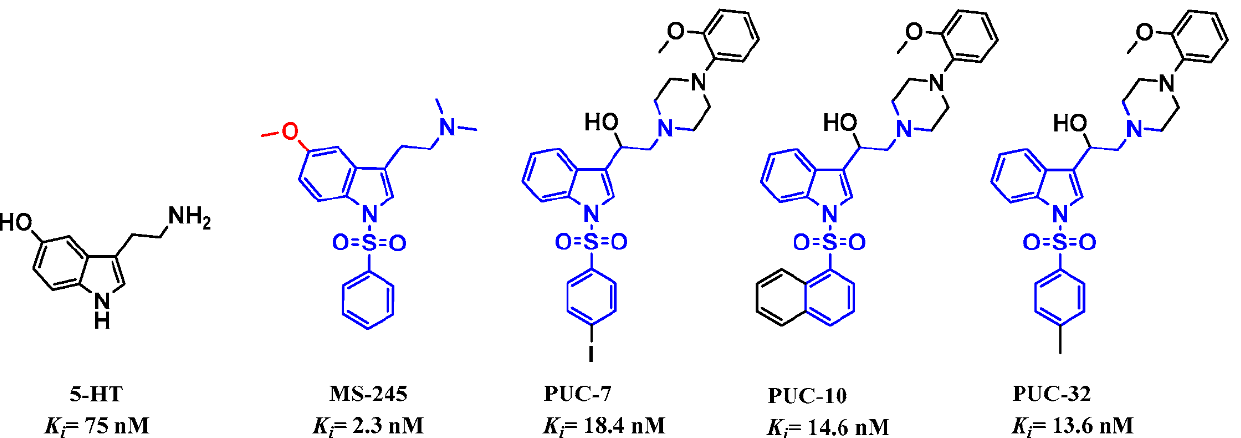
Figure 1. Structures and inhibition constants (K i ) for 5-HT [18], MS-245 [19,20], and examples of our previously reported N -arylsulfonylindole antagonists over the 5-HT 6 receptor [17].